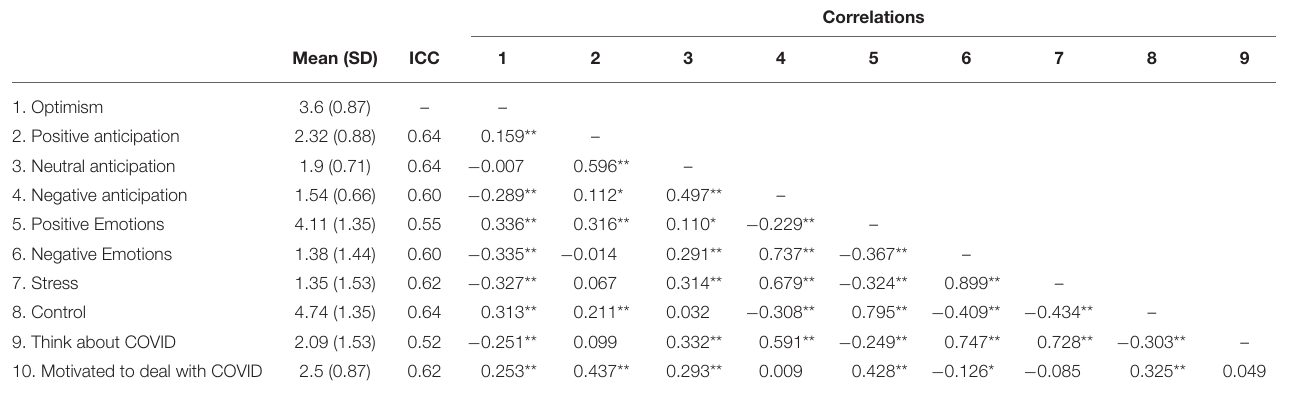
TABLE 1 | Descriptives and correlations among the variables of